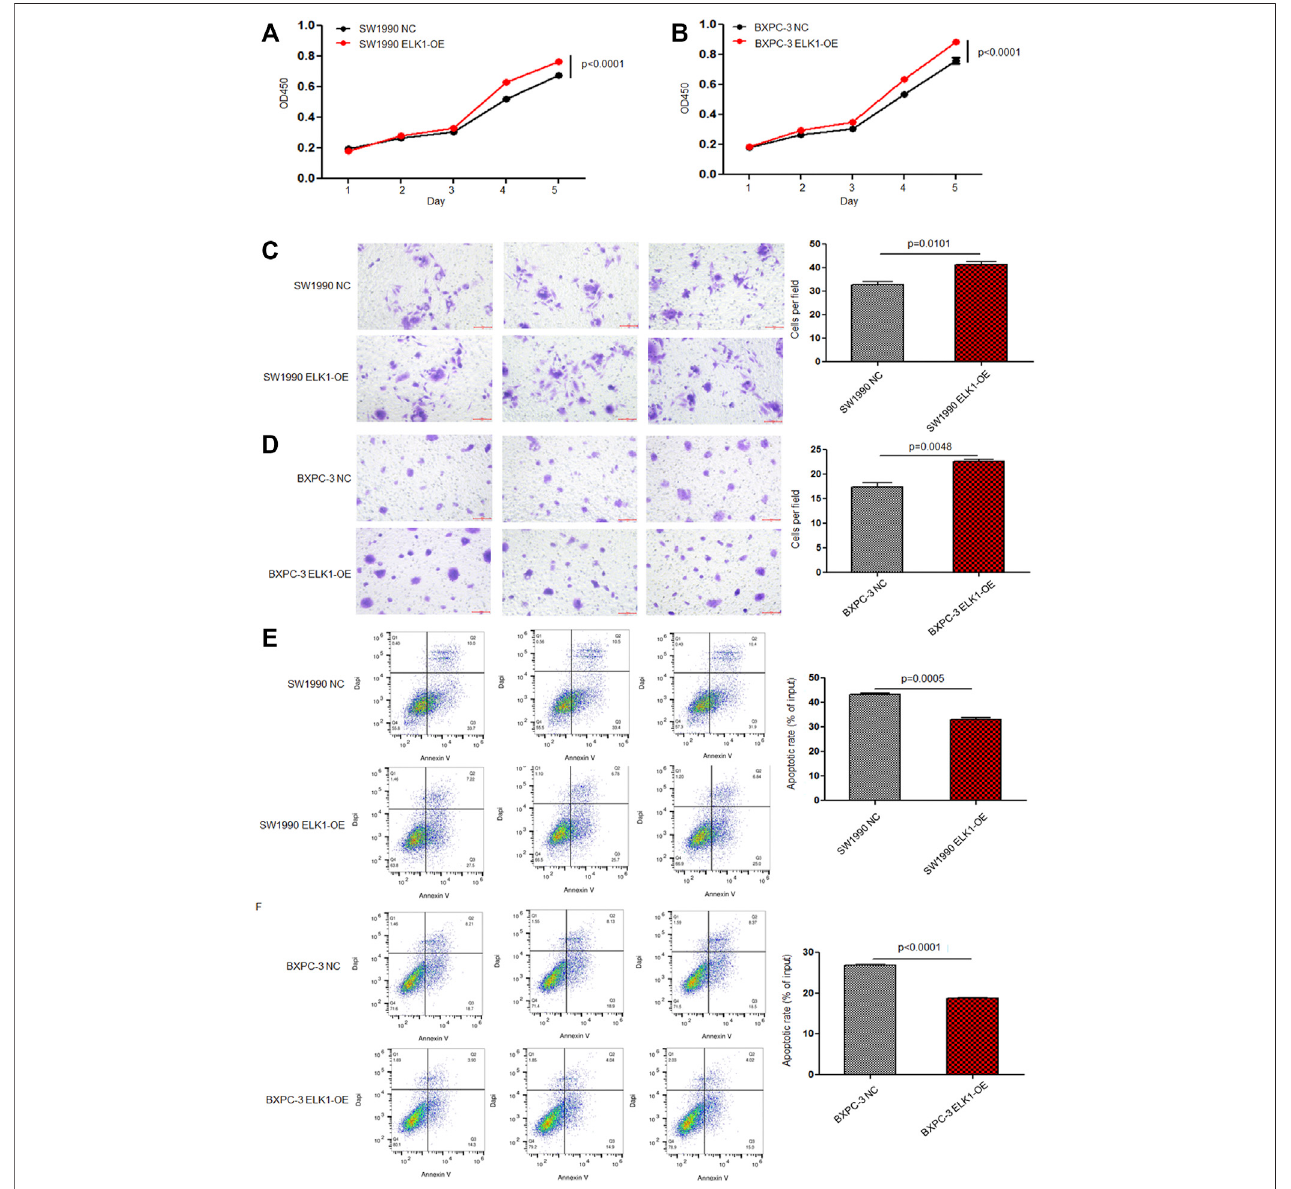
FIGURE 5 | ELK1 overexpression promoted pancreatic cancer cells proliferation, invasion and survival. (A , B) CCK8 analysis of SW1990 and BxPC3 cells with or without ELK1 overexpression. * p < 0.001, ** p < 0.001, between ELK1-OE group and control group in SW1990 and BxPC3 cells. (C , D) Matrigel-Transwell analysis of SW1990 and BxPC3 cells with or without ELK1 overexpression. * p (cid:1) 0.0101, ** p (cid:1) 0.0048, between ELK1-OE group and control group in SW1990 and BxPC3 cells. (E , F) FACS apoptotic analysis of SW1990 and BxPC3 cells with or without ELK1 overexpression. * p (cid:1) 0.0005, ** p < 0.001, between ELK1-OE group and control group in SW1990 and BxPC3